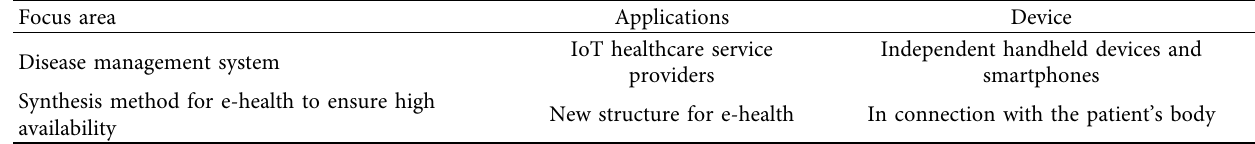
Table 3: IoT healthcare